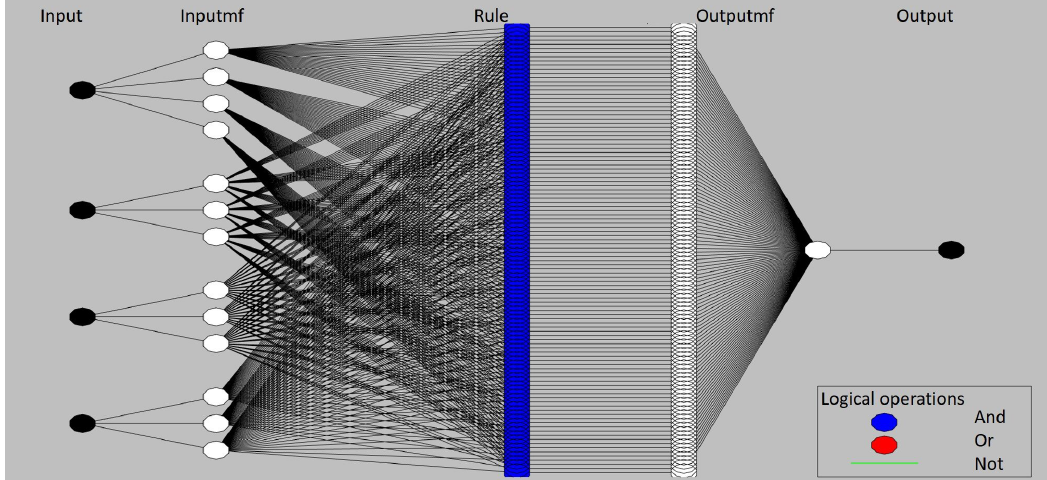
Figure 4. ANFIS structure.